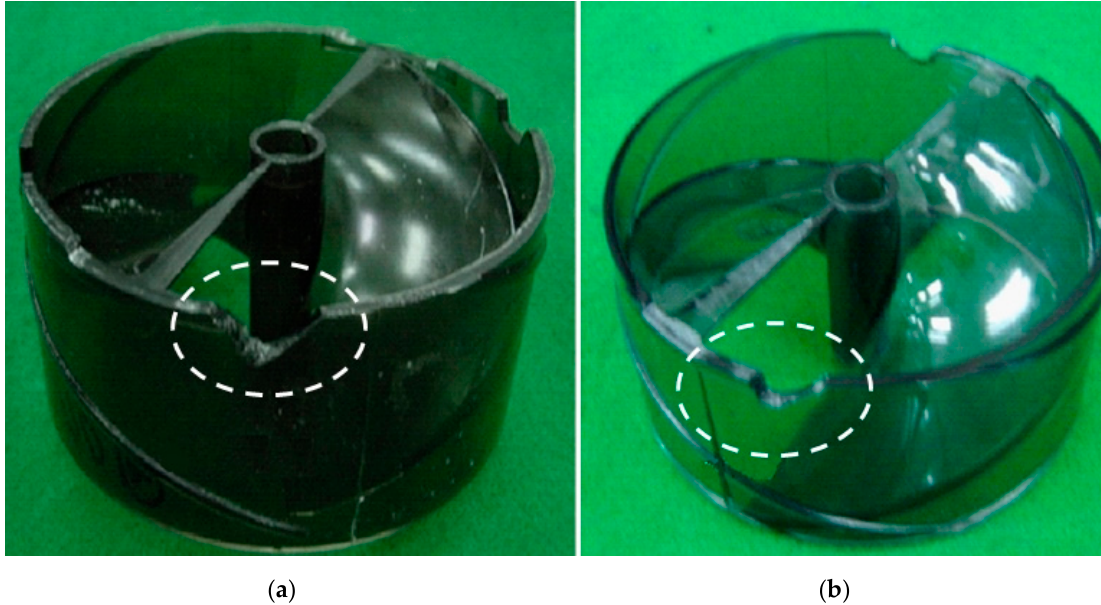
Figure 9. Failed helix upper dispensers in field and during the first ALT. ( a ) Failed product in field; ( b ) Product with crack after first ALT.